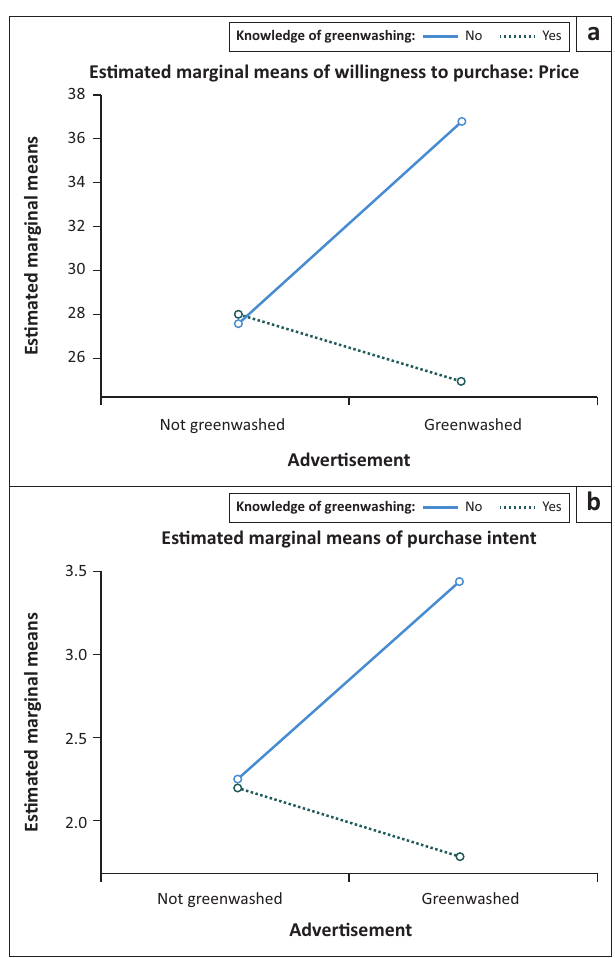
FIGURE 1: Two-way interaction effect on Willingness to pay and Purchase intent (a–b)